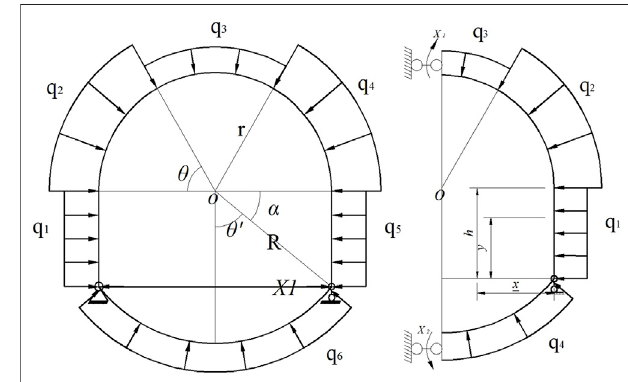
FIGURE 8 | Double arch truss analysis diagram by external